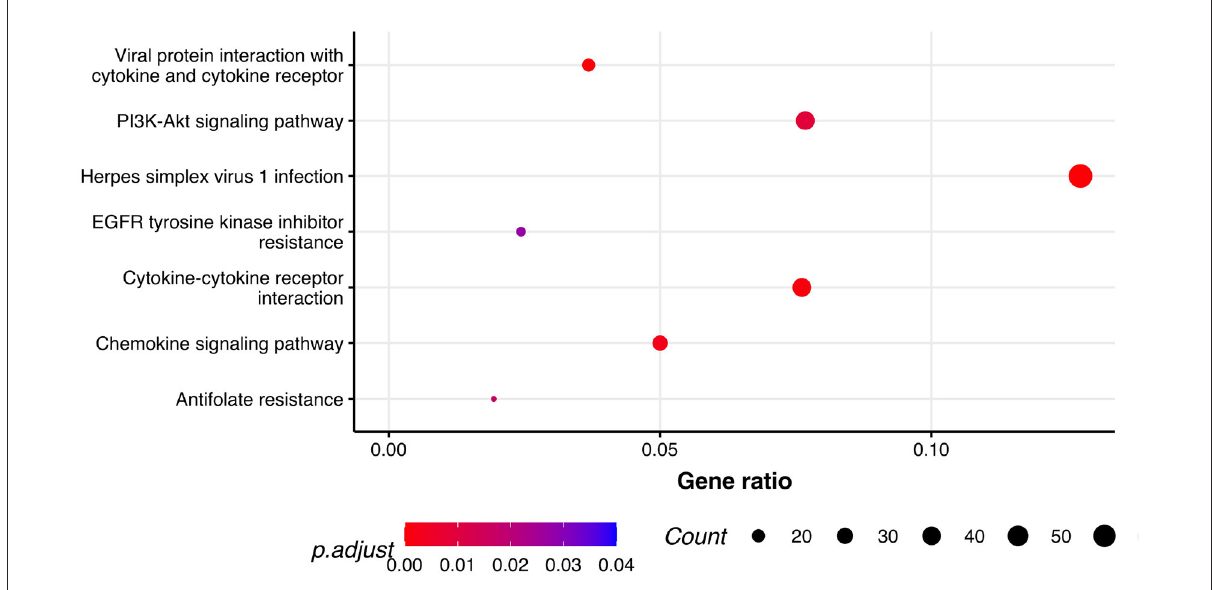
FIGURE2 Pathway analysis. Dot plot of the statistically significant KEGG pathways shared between all the phenotypes. Gene ratio represents genes related to KEGG pathway/total number of significantly differentially expressed genes and count is the number of genes that belong to a given pathway.